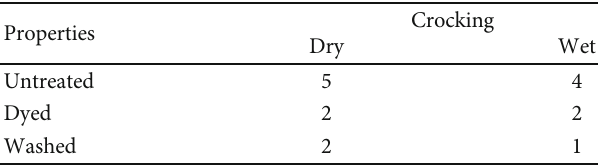
Table 3: Rating of color fastness to crocking of untreated, dyed and washed fabrics at temperature 80 ° C for 60min at a dye concentration of 6% w / v and liquor ratio of 1:30.